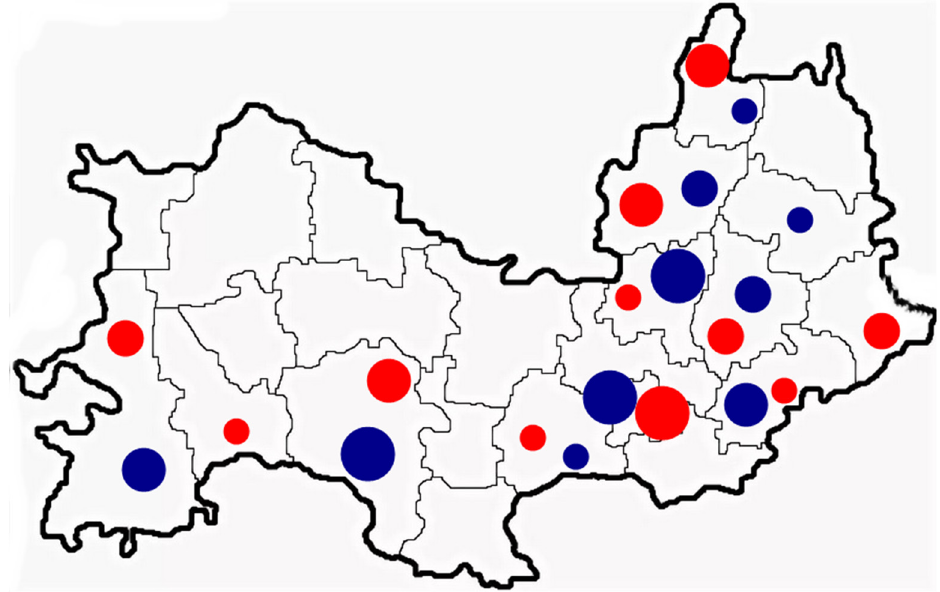
Figure 4. Distribution and magnitude of cases of infection with HFRS (red circles) and tularemia (blue circles) among people of Mordovia.